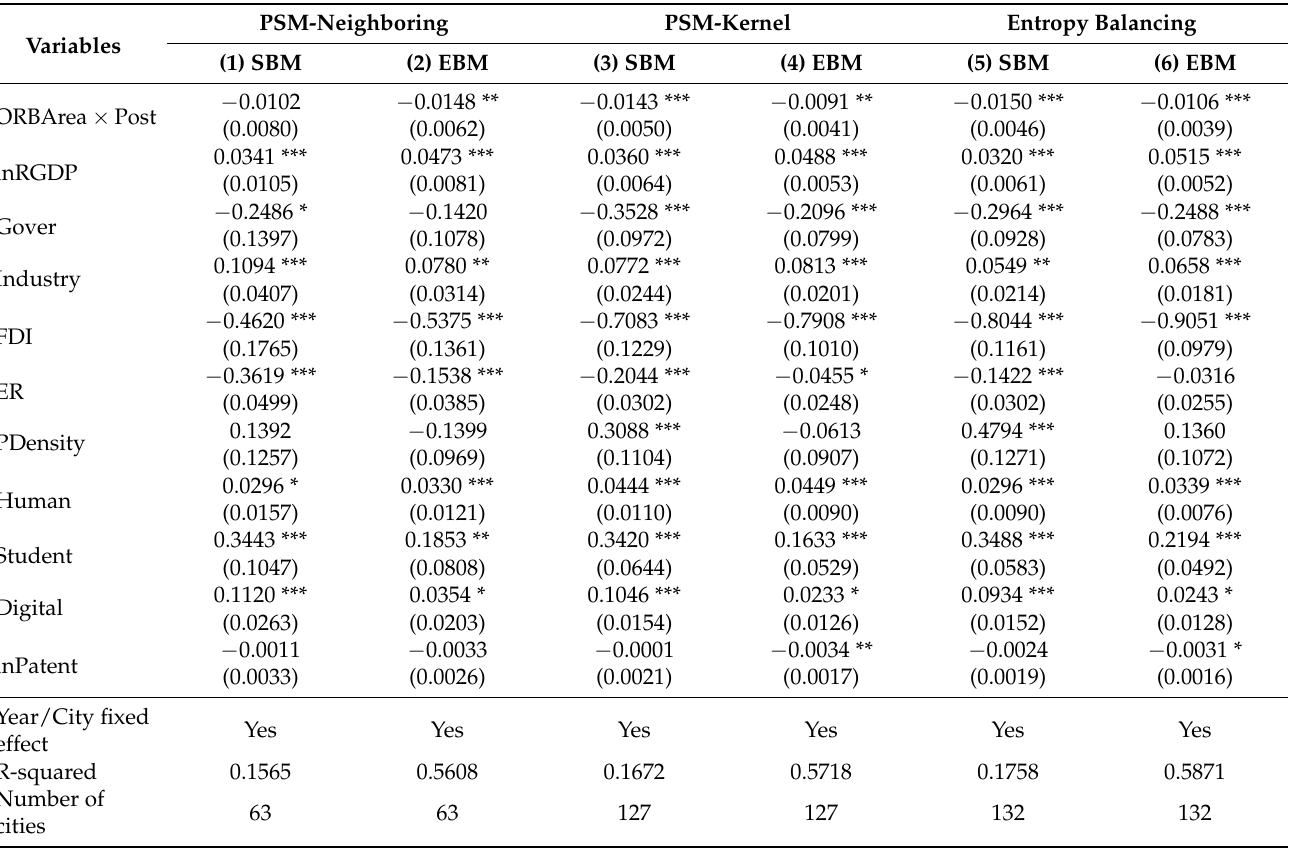
Table 6. Empirical results of the DID regression based on the matched